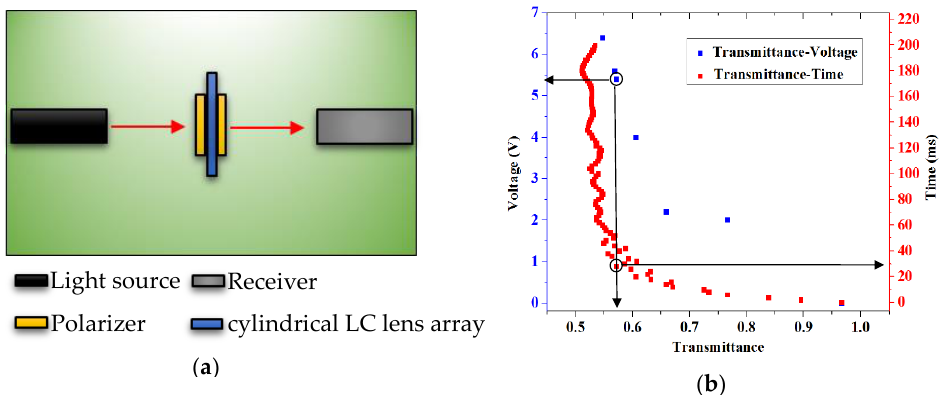
Figure 10. ( a ) Response time measurement platform and ( b ) response time of the cylindrical LC lens array.